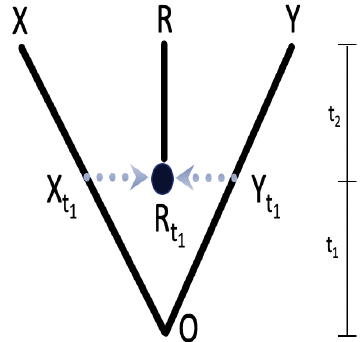
Figure 1. A three-taxa phylogenetic network. The hybrid species R of X and Y on the tips of the network was formed at t = t 1